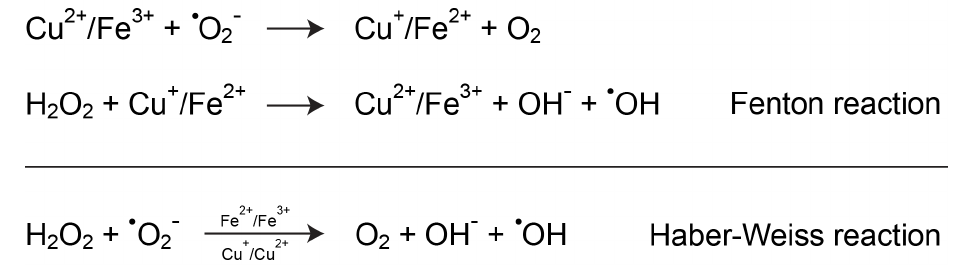
Figure 3. Copper-mediated increase of oxidative stress. Copper can participate in Fenton and Haber–Weiss reactions, which lead to the formation of the highly reactive hydroxyl radical intermediate, either directly or indirectly by interfering with iron homeostasis.